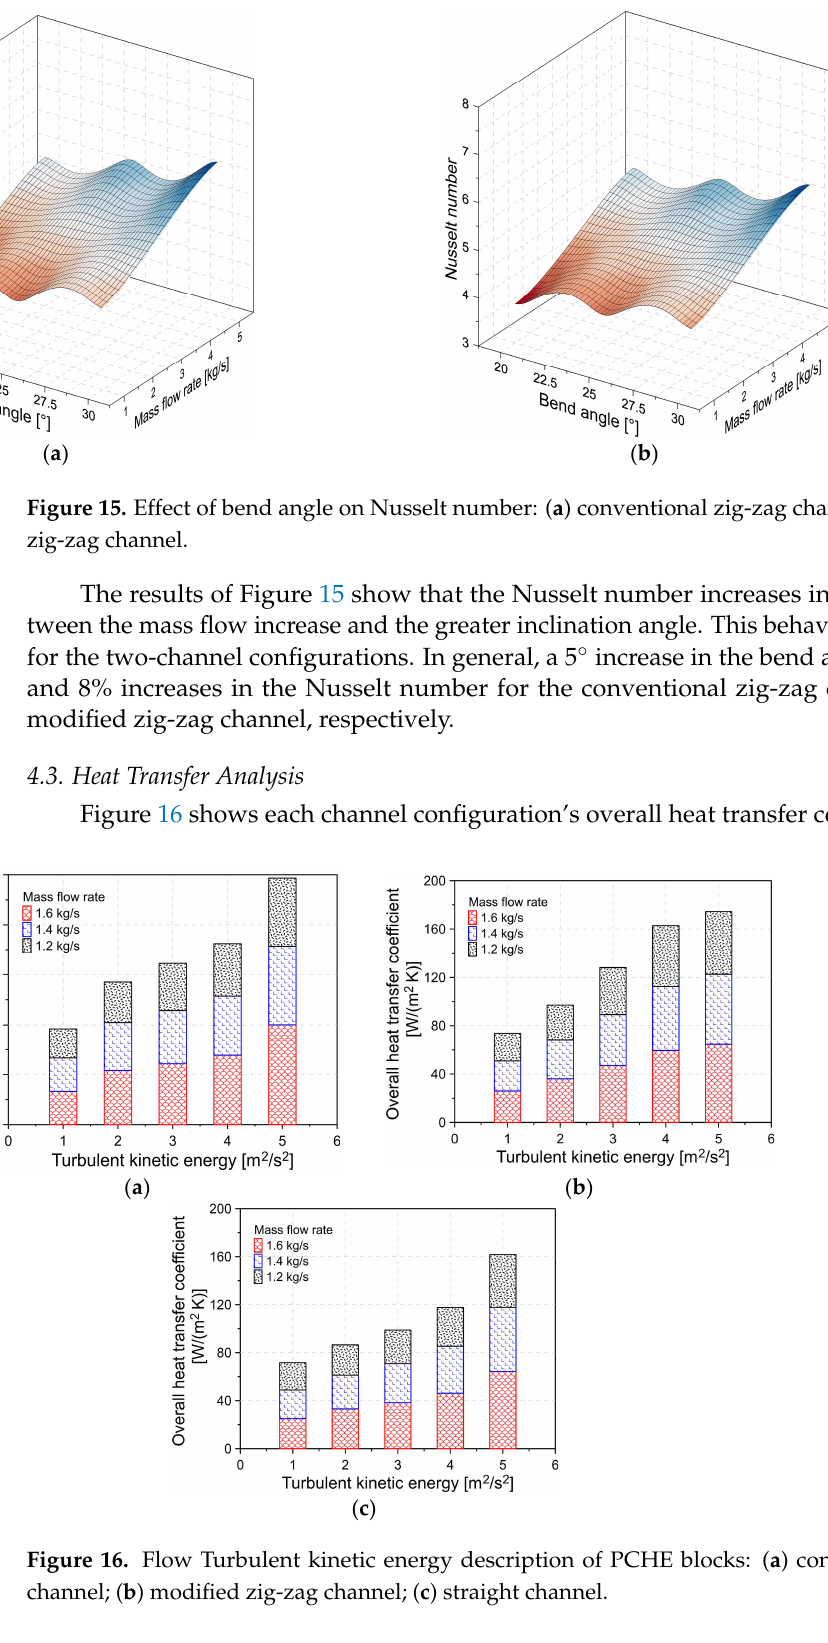
Figure 14. Effect of bend angle on friction factor: ( a ) conventional zig-zag channel; ( b ) modified zig- zag channel.